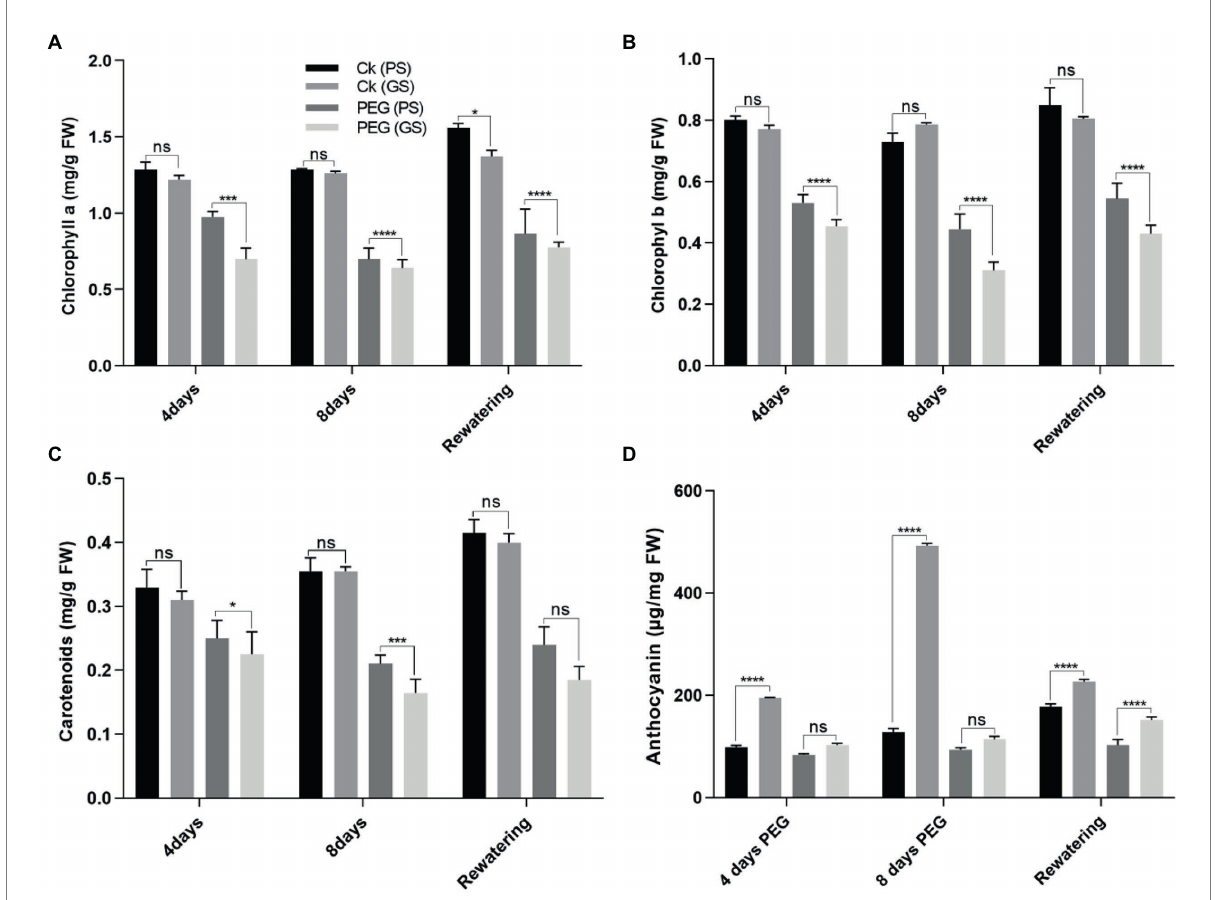
FIGURE 2 Purple and green stem Brassica napus plants under drought (10% PEG-6000), (A) chlorophyll a, (B) chlorophyll b, (C) carotenoids, and (D) anthocyanins, respectively. Different symbols represents significance level as * p = 0.05, ** p = 0.01, *** p = 0.001, **** p = 0.0001. ns, non-